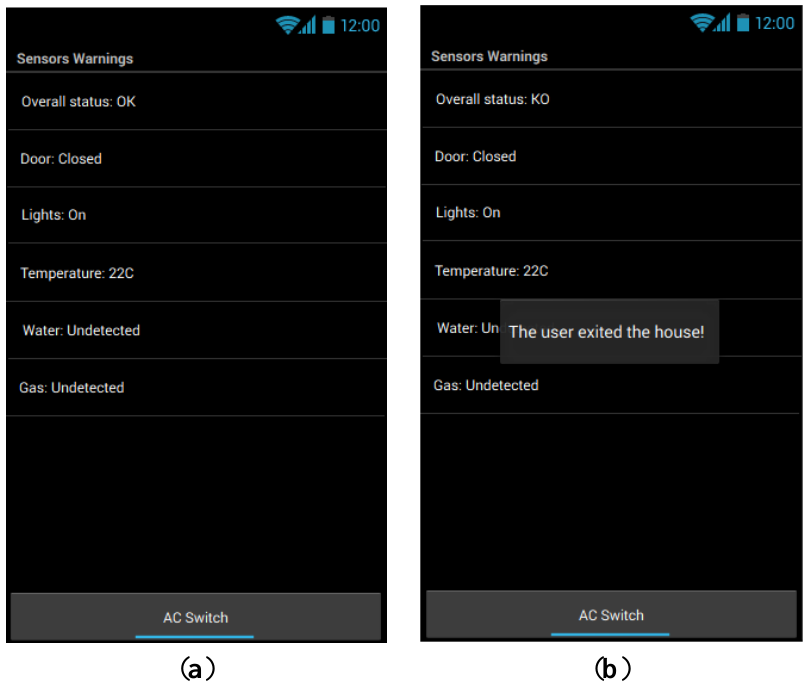
Figure 7. ( a ) The visual state representing the stabilized context ―initial‖ which means that the user is out of the sensors reach and the last five previous states are equal. ( b ) The user has performed the action of ―leaving the house‖ which involves the motion sensors and door sensor.